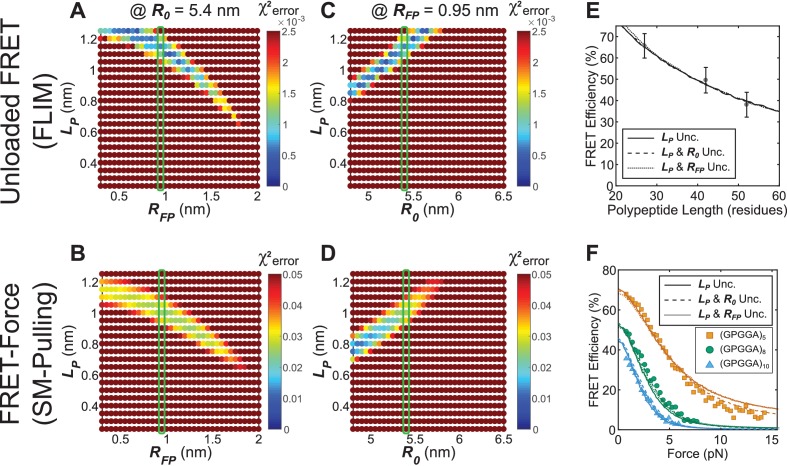
Parameter constraint has minimal effects on measurement of polypeptide persistence length (LP) for TSMod-like constructs in unloaded or loaded conditions.(A, B) Heatmaps of chi-squared error of model fits to published fluorescence-force spectroscopy measurements of (GPGGA)5,8,10 extensible domains flanked by Cy3 and Cy5 fluorescent dyes in unloaded (A) and loaded (B) conditions; literature estimate of RFP used for parameter constraint highlighted with green bar; R0 is constrained to 5.4 nm. (C, D) As in panels (A and B), except various R0 and LP parameters were examined; green bar highlights R0 parameter estimate; RFP is constrained to 0.95 nm. (E, F) Model fits to published fluorescence-force spectroscopy data of TSMod-like constructs in unloaded (E) and loaded (F) conditions are equally accurate with either a single unconstrained (unc.) parameter (LP) or two unconstrained parameters.